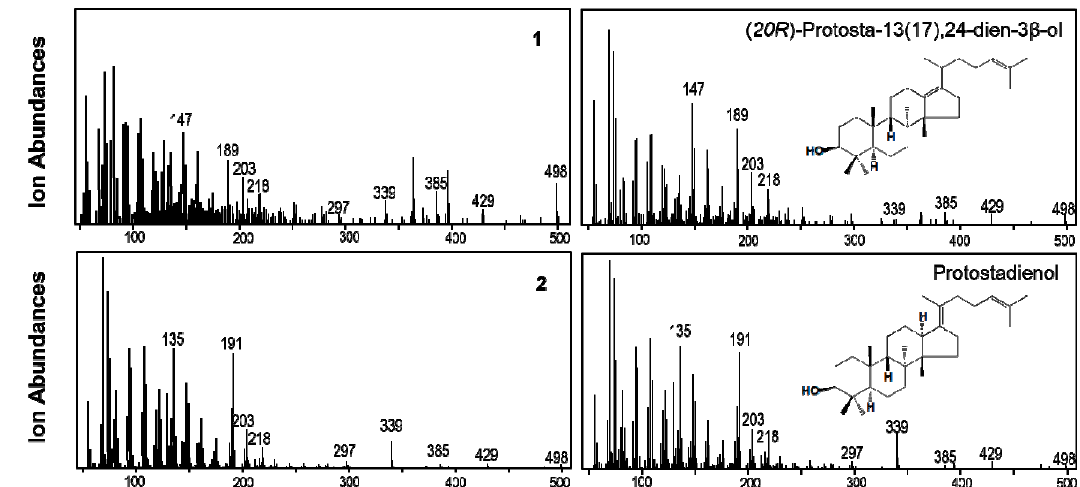
Figure 5. Identification of triterpenoids in CfaOSC2-overexpressing yeast cells by gas chromatography–mass spectrometry (GC–MS) analysis. ( a ) GC chromatograms from the strain expressing the CfaOSC2 gene, the control yeast strain harboring the pYES2 vector, and the authentic standards from the yeast strain co-expressing AfuOSC3 / CYP5081A1 genes. IS means internal standard (Lupeol). ( b ) MS spectra of trimethylsilylated triterpenoids produced from the CfaOSC2-expressing strain (left) and the standard (right).